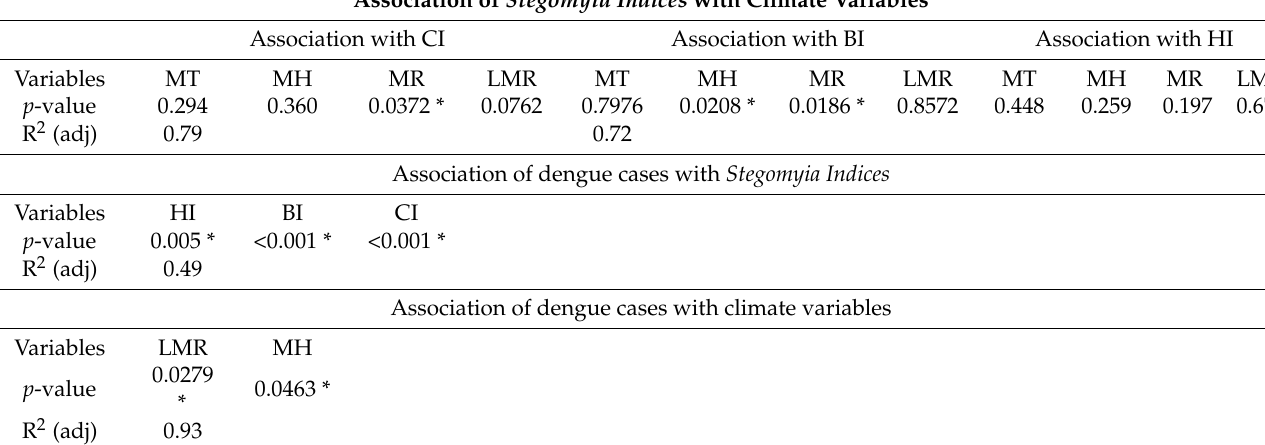
Table 2. Association between the Stegomyia indices and climate variables, dengue cases with the Stegomyia indices and dengue cases with climate